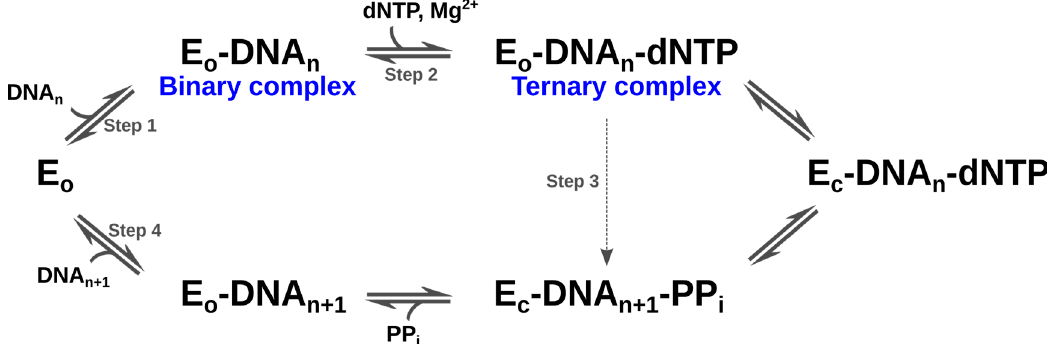
Figure 4. Schematic representation of the catalytic mechanism of Pol β . E o and E c correspond to the open and closed conformations of the enzyme. Sequential binding of the DNA (DNA n ) and dNTP leads to the formation of the binary (step 1) and ternary complexes (step 2), respectively. Subsequent conformational rearrangement of the enzyme ( E c ) aligns the active site for catalysis (step 3). The chemical step of catalysis is followed by the release of pyrophosphate (PP i ) and the DNA product (DNA n +1 ) (step 4). Figure adapted from [108,109].